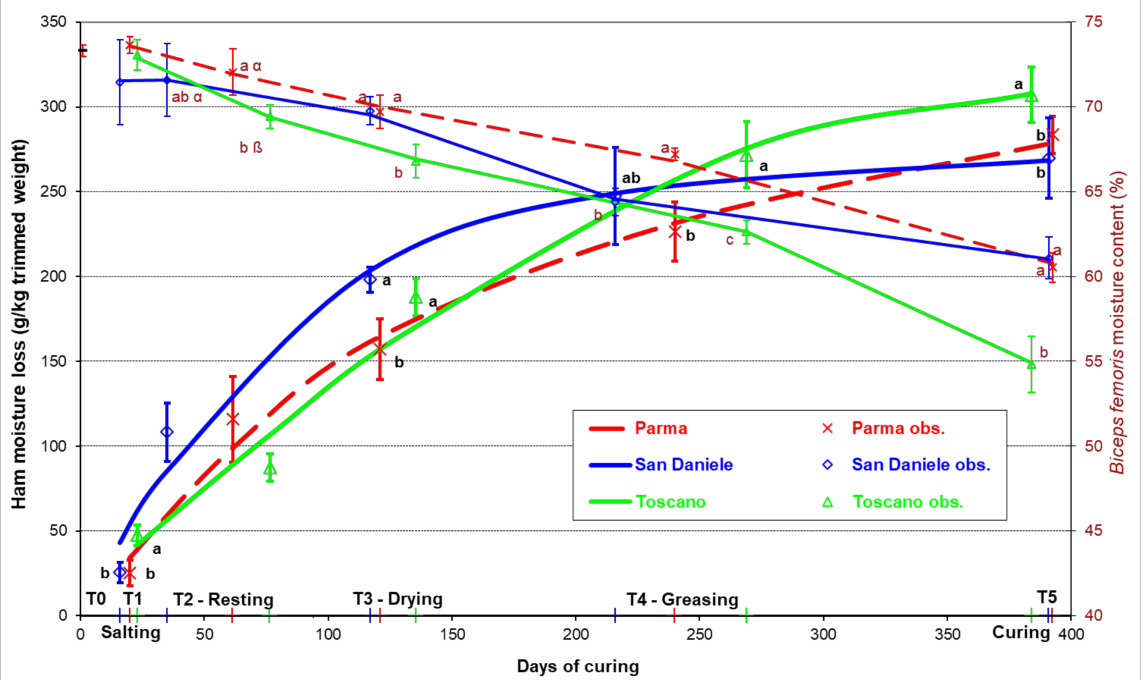
Figure 1. Evolution of the moisture loss in the whole ham and of the moisture content in the biceps femoris muscle during the processing of the main Italian prosciutto PDOs (obs. = observed mean with standard deviation values). Along the x –axis, the days from slaughtering of the various ripening phases of the three PDOs ham are also reported (a, b, c: differences between PDOs within a ripening phase p ≤ 0.05; α , β : differences between PDOs within the ripening phase p ≤